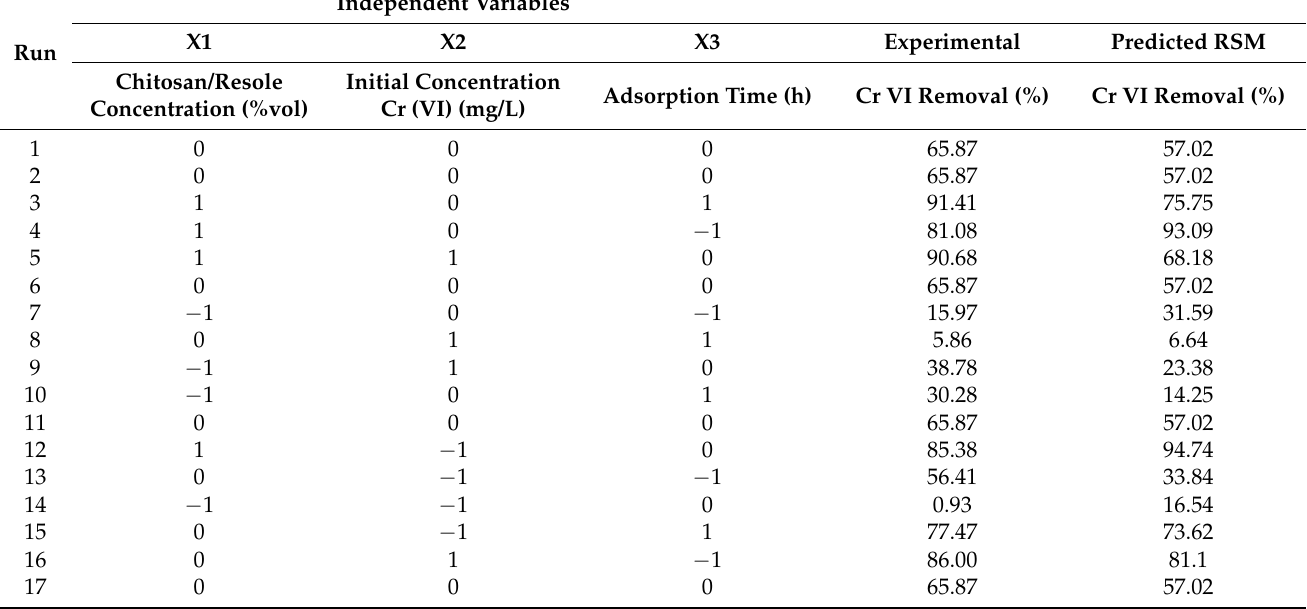
Table 4. Box–Behnken